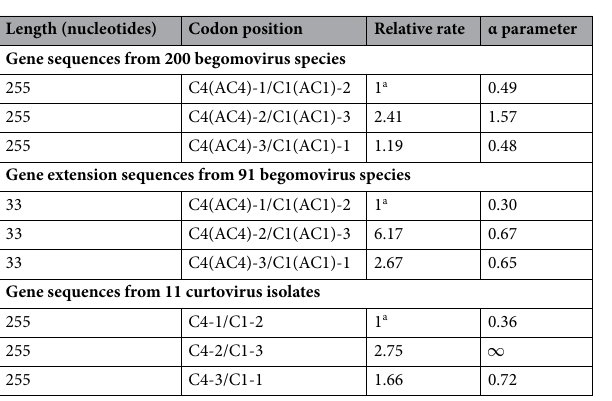
Table 2. Codon-site nucleotide variation in C4(AC4) and C1(AC1) overlapping regions. a The estimated substitution rates are determined relative to this position. For codon position, refer to Fig.